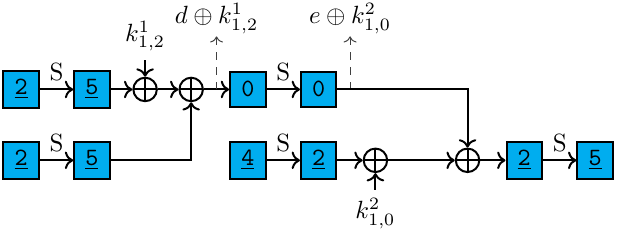
represents the r,c and e ⊕ k 2 represent the possible input and output 1 , 2 1 , 0